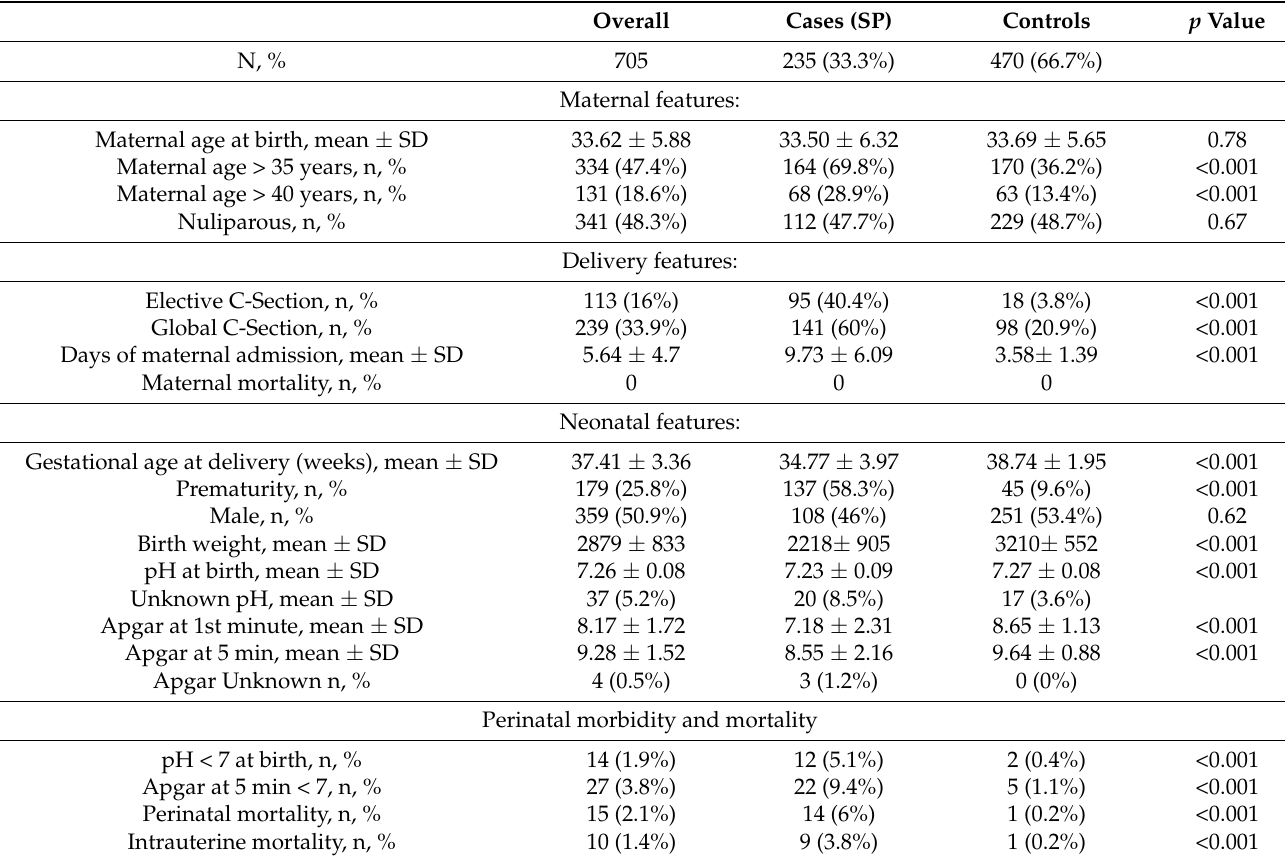
Table 1. Comparative analysis of the distribution of clinical variables in all pregnant women, as well as between cases of severe preeclampsia (SPG) and their controls. Variables are expressed by mean ± SD and n (%).